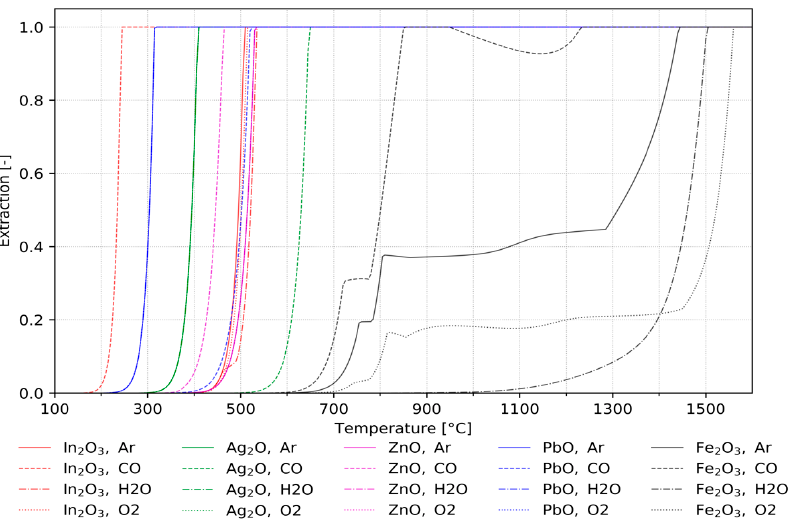
Figure 3 . Influence of temperature and atmosphere on the extraction rates from mock jarosite . Figure 3. Influence of temperature and atmosphere on the extraction rates from mock